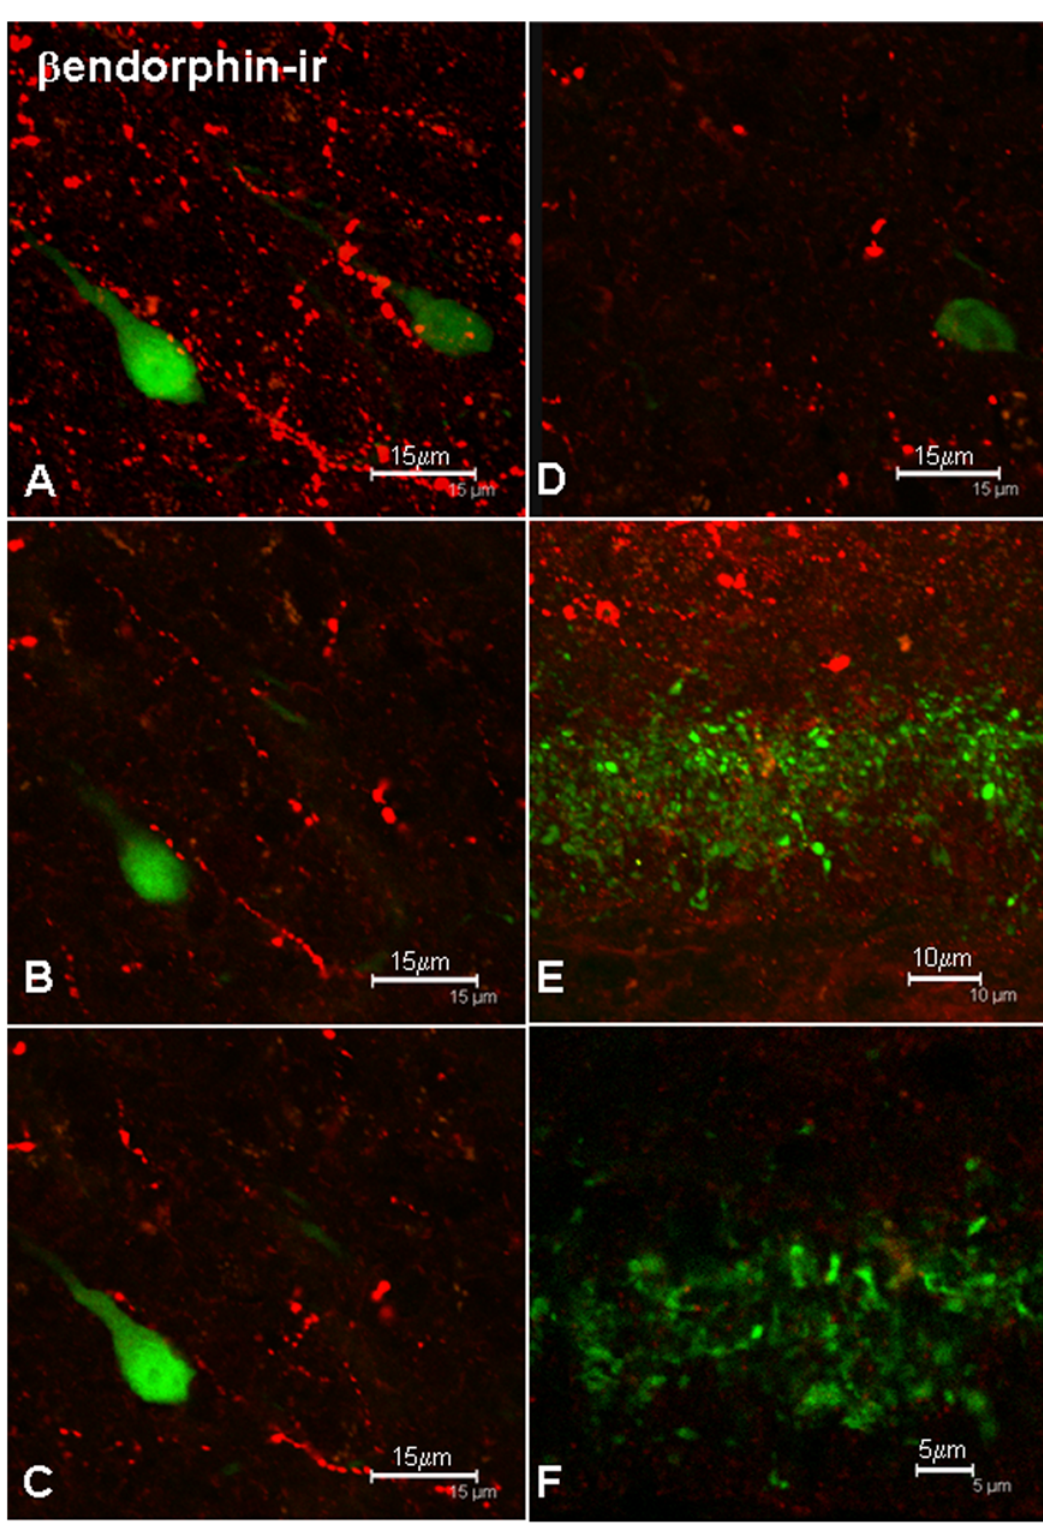
Figure 4. Examples of close appositions between b -endorphin-ir fibers (red) and GnRH-GFP perikarya and processes (green) in a maximum intensity projection of the image stack (A) and in single 0.5 m m optical slices (B–D). A few close appositions were also observed between b -endorphin-ir fibers and GnRH neuroterminals in the median eminence ( E ), confirmed by analysis of single 0.5 m m optical slices ( F ). Scale bars=15 m m ( A–D ), 10 m m ( E ), 5 m m ( F ).